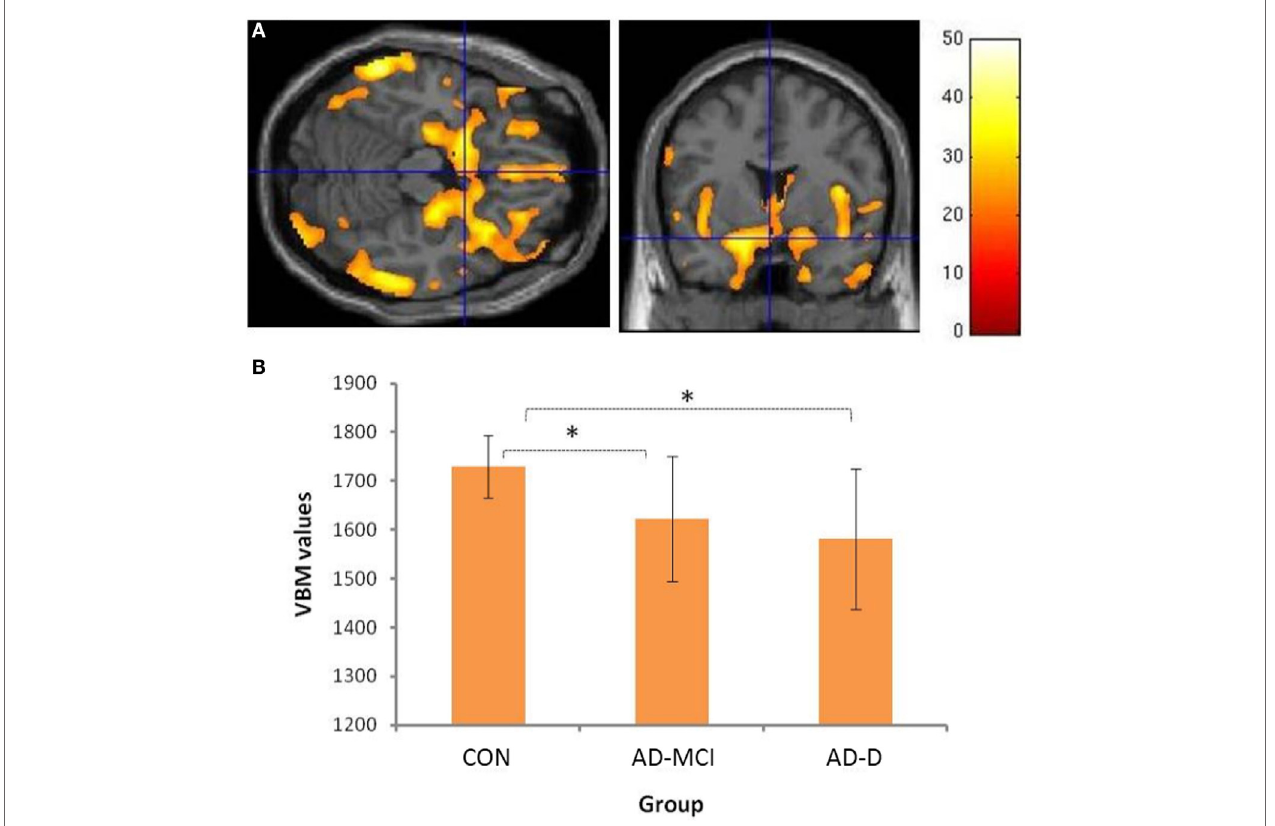
FigUre 1 | Volumetric group differences across healthy controls (cOn), patients with mild cognitive impairment due to alzheimer’s disease (aD-Mci), and patients with dementia due to alzheimer’s disease (aD-D) . (a) shows the main effect of groups with respect to atrophy in gray matter regions; Bar represents T -values; p < 0.05, FWE corrected. Please cf. to Table S1 in Supplementary Material for details of involved clusters. (B) The y -axis denotes VBM values of amygdala (mean of bilateral ROI voxels) for groups depicted on x -axis. Asterisks indicate significant differences, Bonferroni-corrected p values: CON–AD- MCI: p = 0.001; CON–AD-D: p < 0.001; AD-MCI–AD-D: p = 0.422. Abbreviations: CON, healthy controls; AD-MCI, patients with mild cognitive impairment due to Alzheimer’s disease; AD-D, patients with dementia due to Alzheimer’s